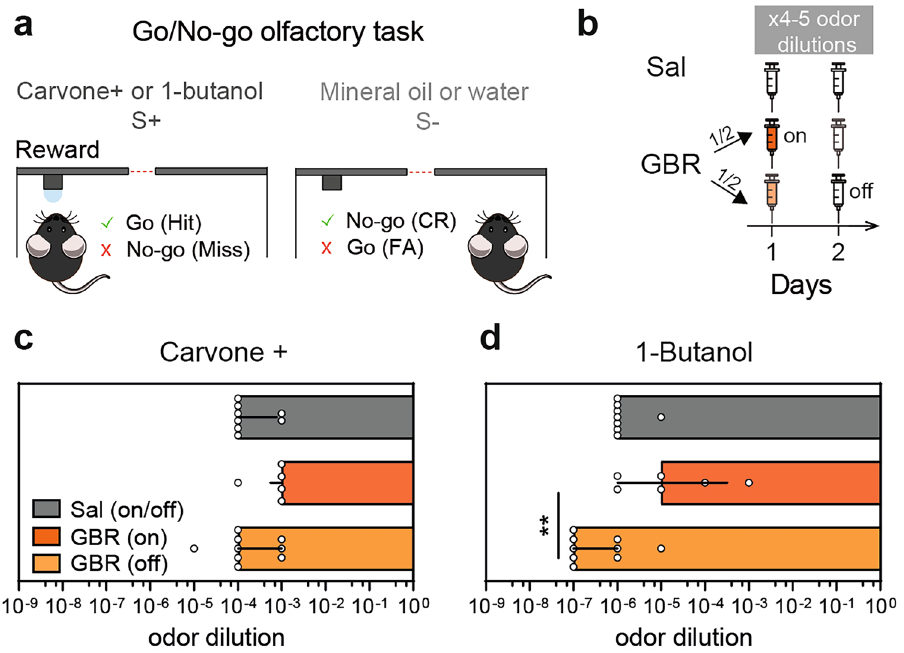
Figure 4. GBR administration does not alter odor detection threshold. ( a ) Schematic of the Go/no-go learning task. In response to S+, licking the water port triggered water delivery. This constitutes a correct response (Go, a hit), whereas not going to lick is considered an error (No-go, a miss). In response to S−, trained mice refrained from licking, thus constituting the correct response (No-go, correct rejection, CR), whereas going to lick constitutes an error (Go, false alarm, FA). ( b ) Experimental timeline and injection protocol. All mice were first trained in a detection task without any treatment (carvone+ (10 –2 ) vs mineral oil; 1-butanol (10 –3 ) vs water, data not shown). Performances were similar for all groups (Mixed-effect model, carvone+, group: F (1.772,14.18) = 0.34, p = 0.691, n = 5–9; 1-butanol, group: F (1.429,11.44) = 0.17, p = 0.778 n = 8–9). ( c , d ) Detection threshold concentration were determined in mice injected with Sal or GBR every other day. Sal and GRB-injected mice were divided in two sub-groups, and the animals were tested 45 min (“on”) or 24 h (“off”) after injections. Sal (on) and (off) showed identical performances and were pooled together (Mann–Whitney test, carvone+, p = 0.429, n = 4; 1-butanol, p > 0.999, n = 4). Odorant concentration (v/v) are given as the dilutions used in the olfactometer. GBR administration does not alter odor detection threshold for both carvone+ ( c ) and 1-butanol ( d ) with respect to the Sal group . A significant difference was found for 1-butanol detection threshold between GBR (on) and (off) (Kruskal–Wallis test, carvone+: p = 0.165; 1-butanol: p = 0.008, followed by Dunn’s test: **p < 0.01). Data are shown as median with interquartile range and individual data